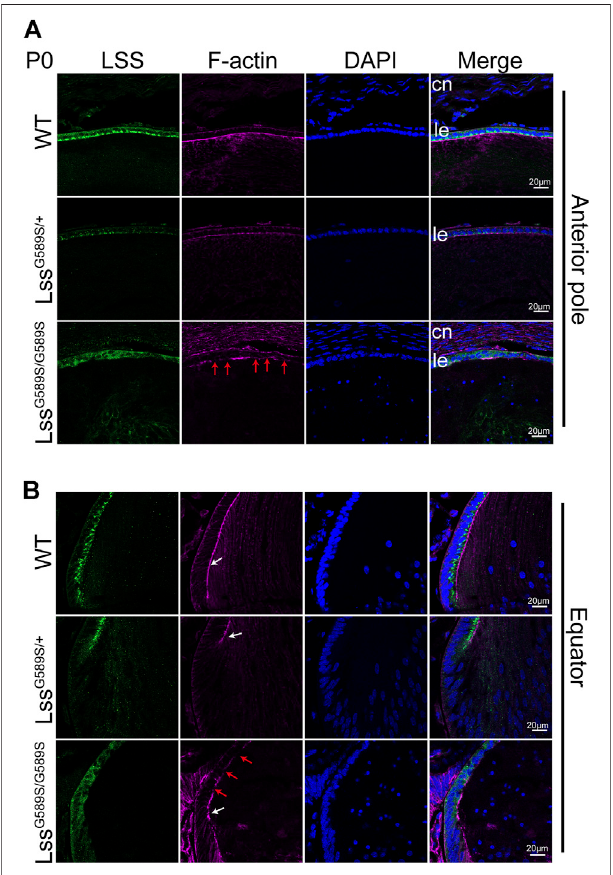
FIGURE 3 | Different distributions of LSS protein in lens epithelial cells at P0. (A) The expression of LSS and its distribution in lens epithelial cells at the anteriorpoleregionofWT,Lss G589S/+ ,andLss G589S/G589S miceatP0. (B) The expressionofLSSanditsdistributioninlensepithelialcellsattheequator region. White arrows indicate EFI, and red arrows indicate discontinuous EFI stained by F-actin. cn, cornea. Le, lens epithelial layer. Scale bar: 20 μ m.